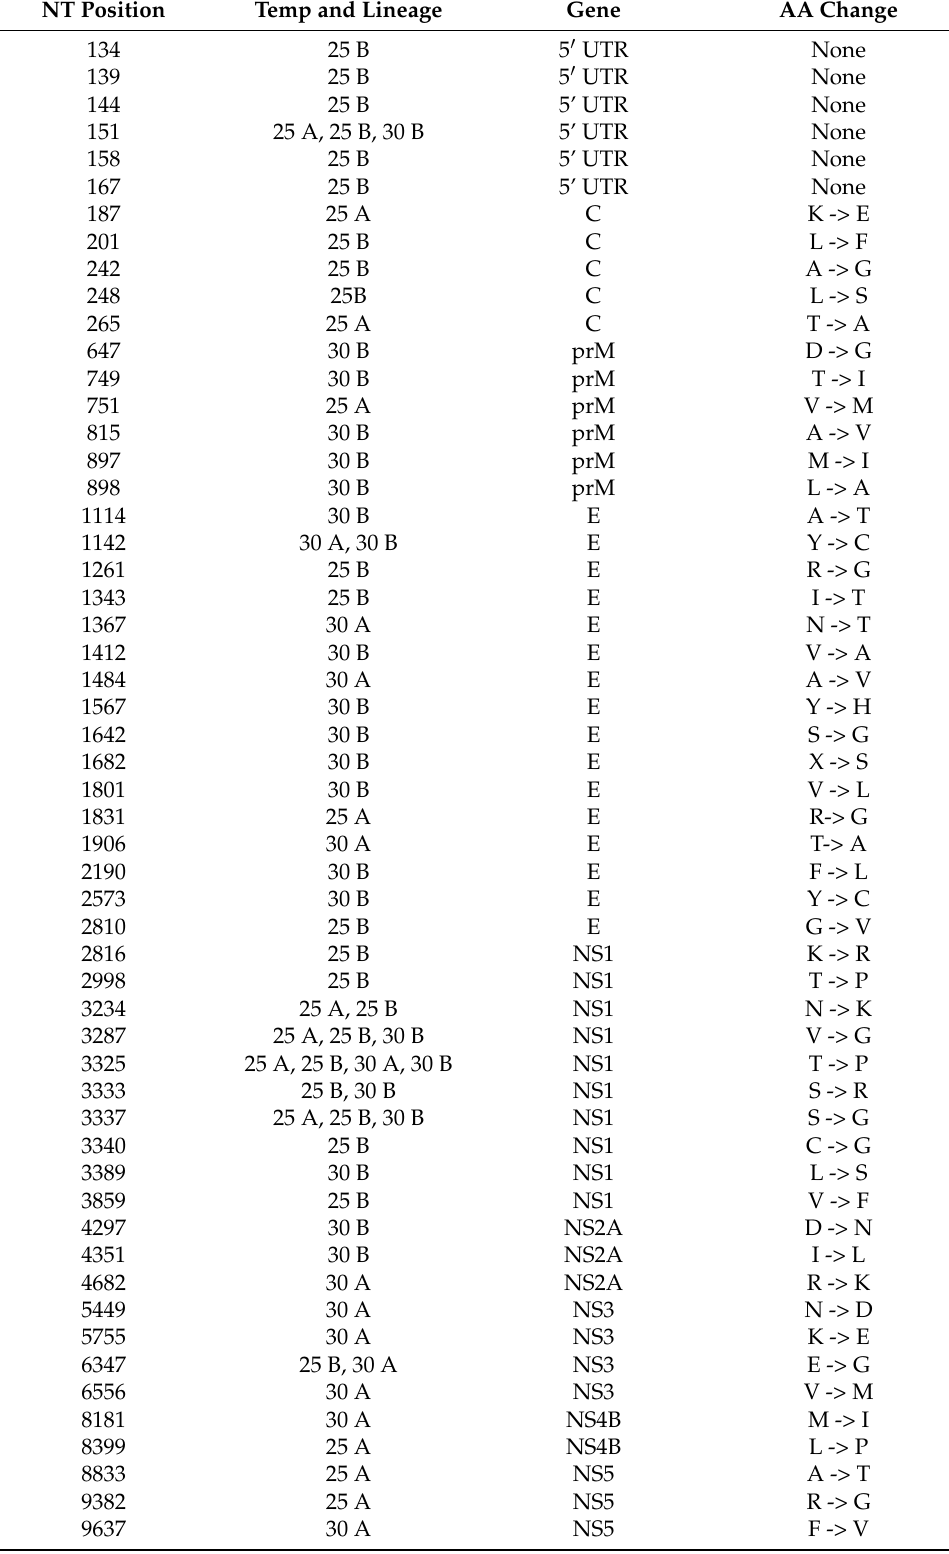
Table 1. Minority nucleotide (NT) and amino acid (AA) changes in >3% of West Nile virus sequences following 12 passages in Culex tarsalis (C × T) cells at 25 ◦ C or 30 ◦